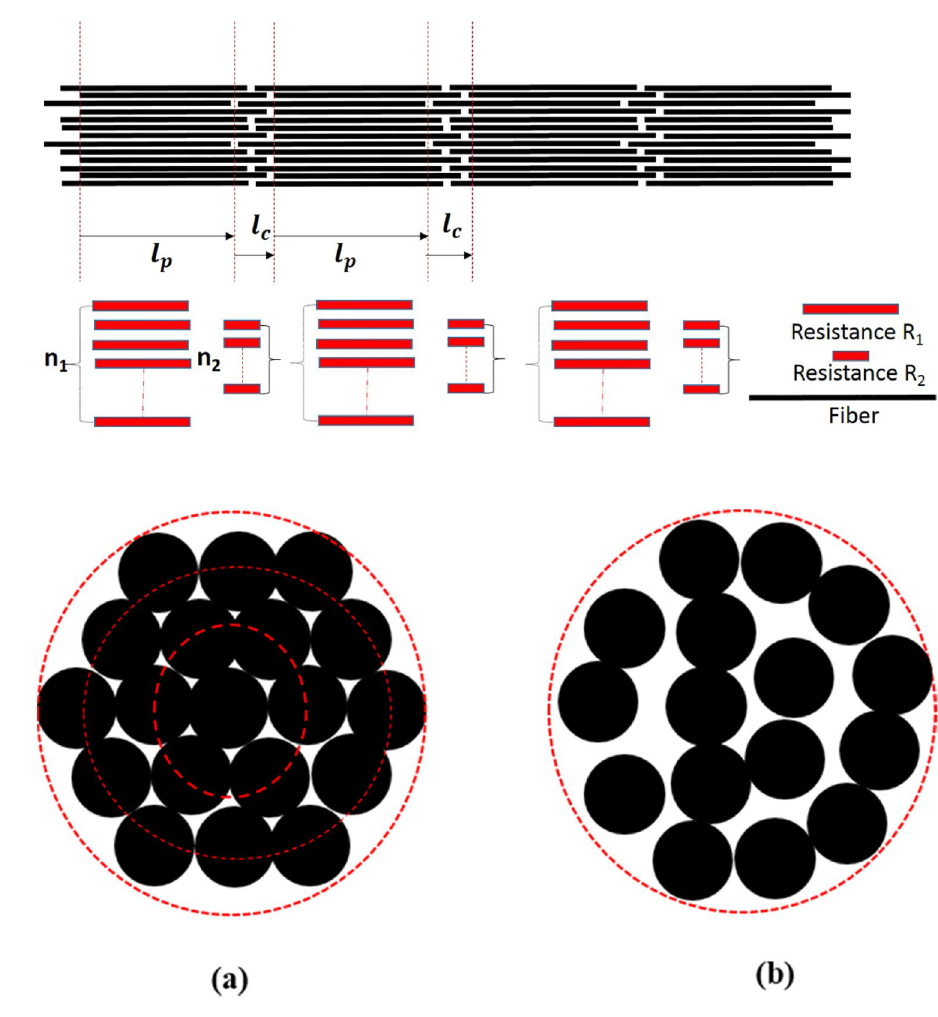
Fig. 3 Schematic diagram of fibers axis distribution and zone connection